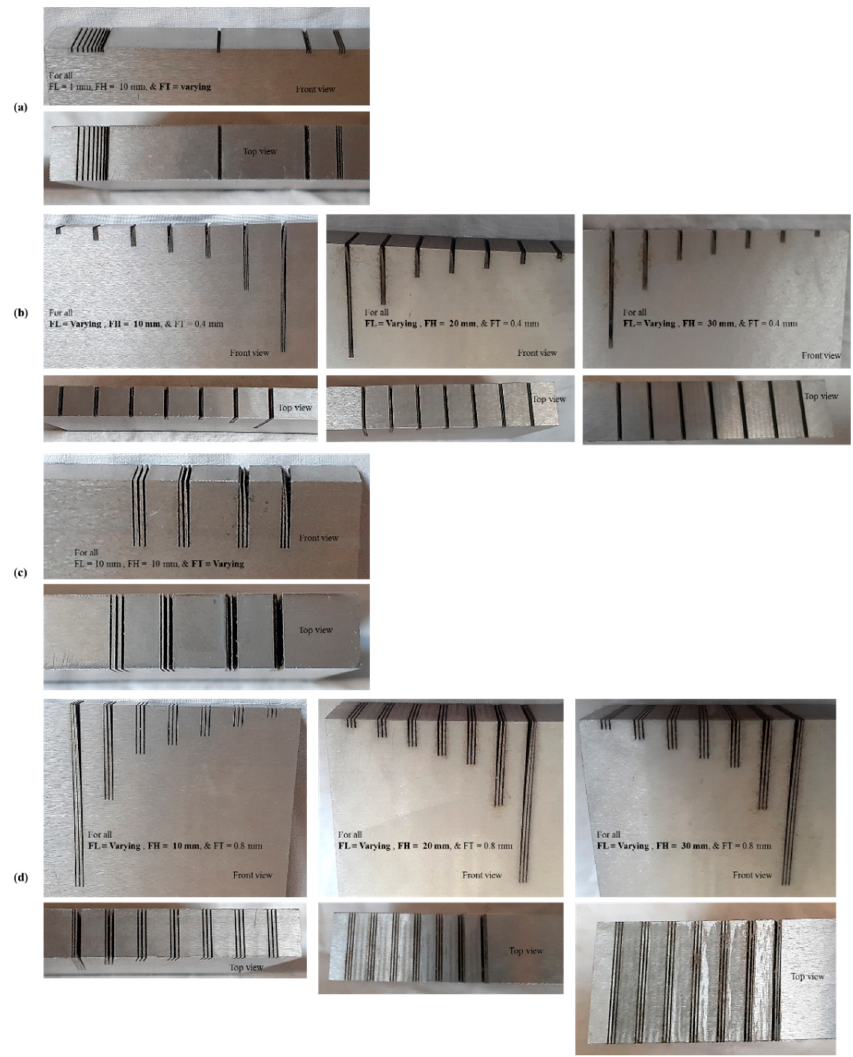
Figure 4. Actual fin structures fabricated on different plates of D2 steel through WEDM. Structures from ( a ) first phase, ( b ) second phase, ( c ) third phase, and ( d ) fourth phase of experimentation.